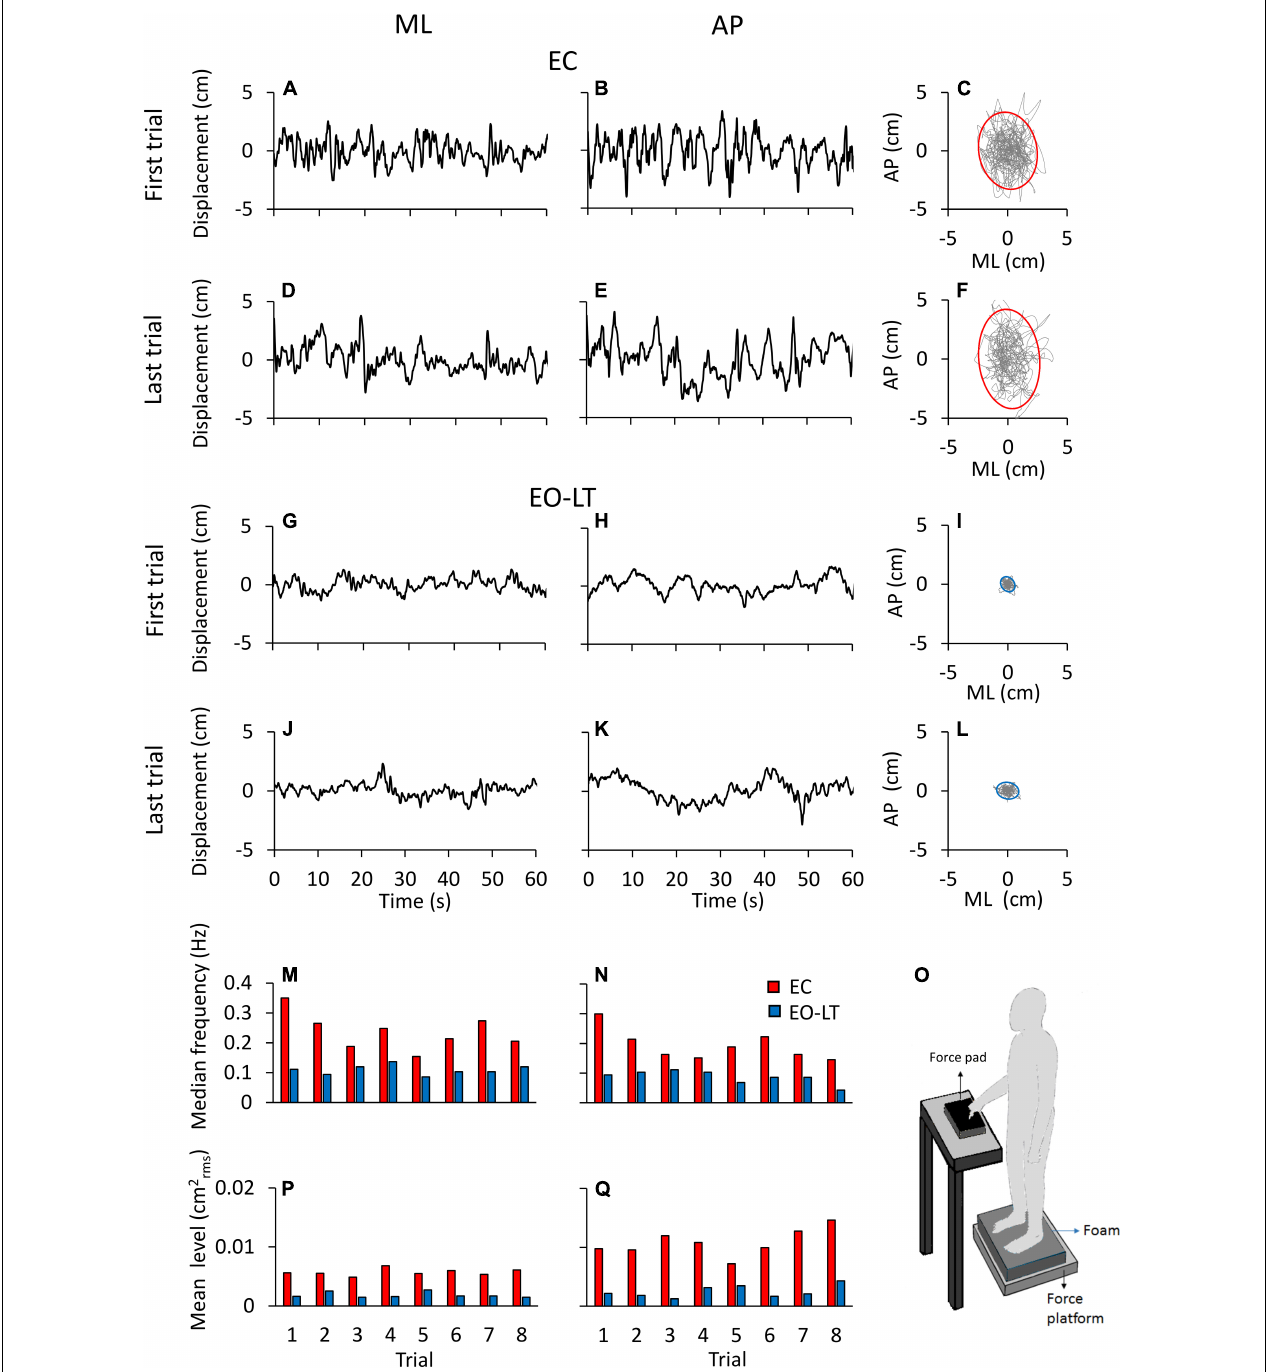
FIGURE 1 | Centre of feet pressure (CoP) excursions and effects of trial repetition on the power spectrum in a representative subject. The recorded CoP displacement in the ML (A,D,G,J) and AP (B,E,H,K) directions are reported for the first and last trials in eyes closed in the absence of touch (EC) (A–E) and eyes open with light-touch (EO-LT) (G–K) conditions. The diagrams of the CoP sway trajectory (grey line) and the 95% ellipse profile (red for EC and blue for EO-LT) are reported in (C,F,I,L) . (M–Q) Show the median frequency and the mean level of the spectrum computed for the 8 trials performed in the EC and EO-LT conditions. In (O) , a sketch of the experimental condition is